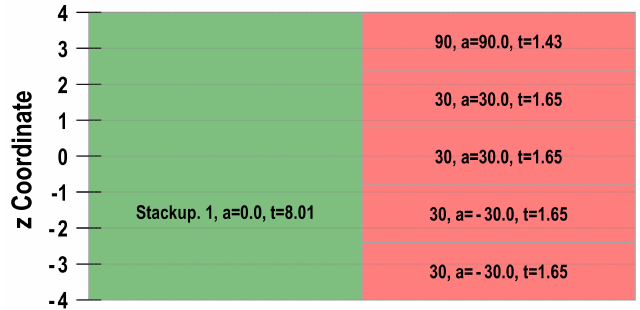
Figure 6. An example of stack-up layers comprising the composite material